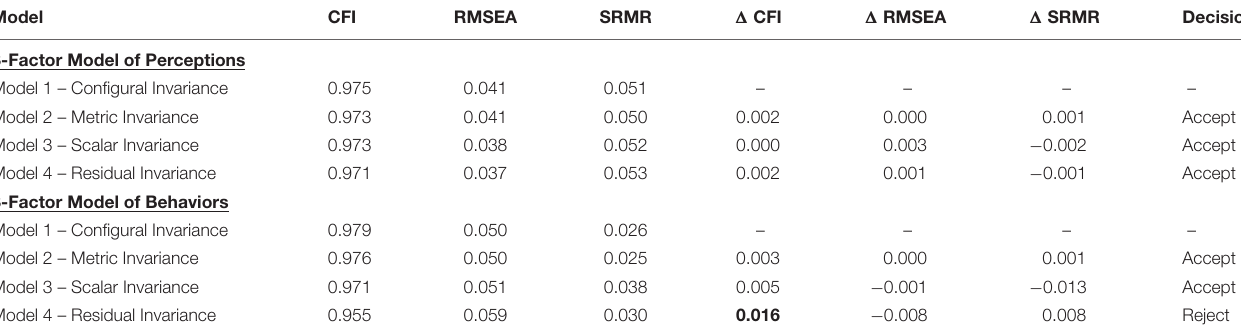
TABLE 3 | Results from tests of measurement invariance based on cohort.